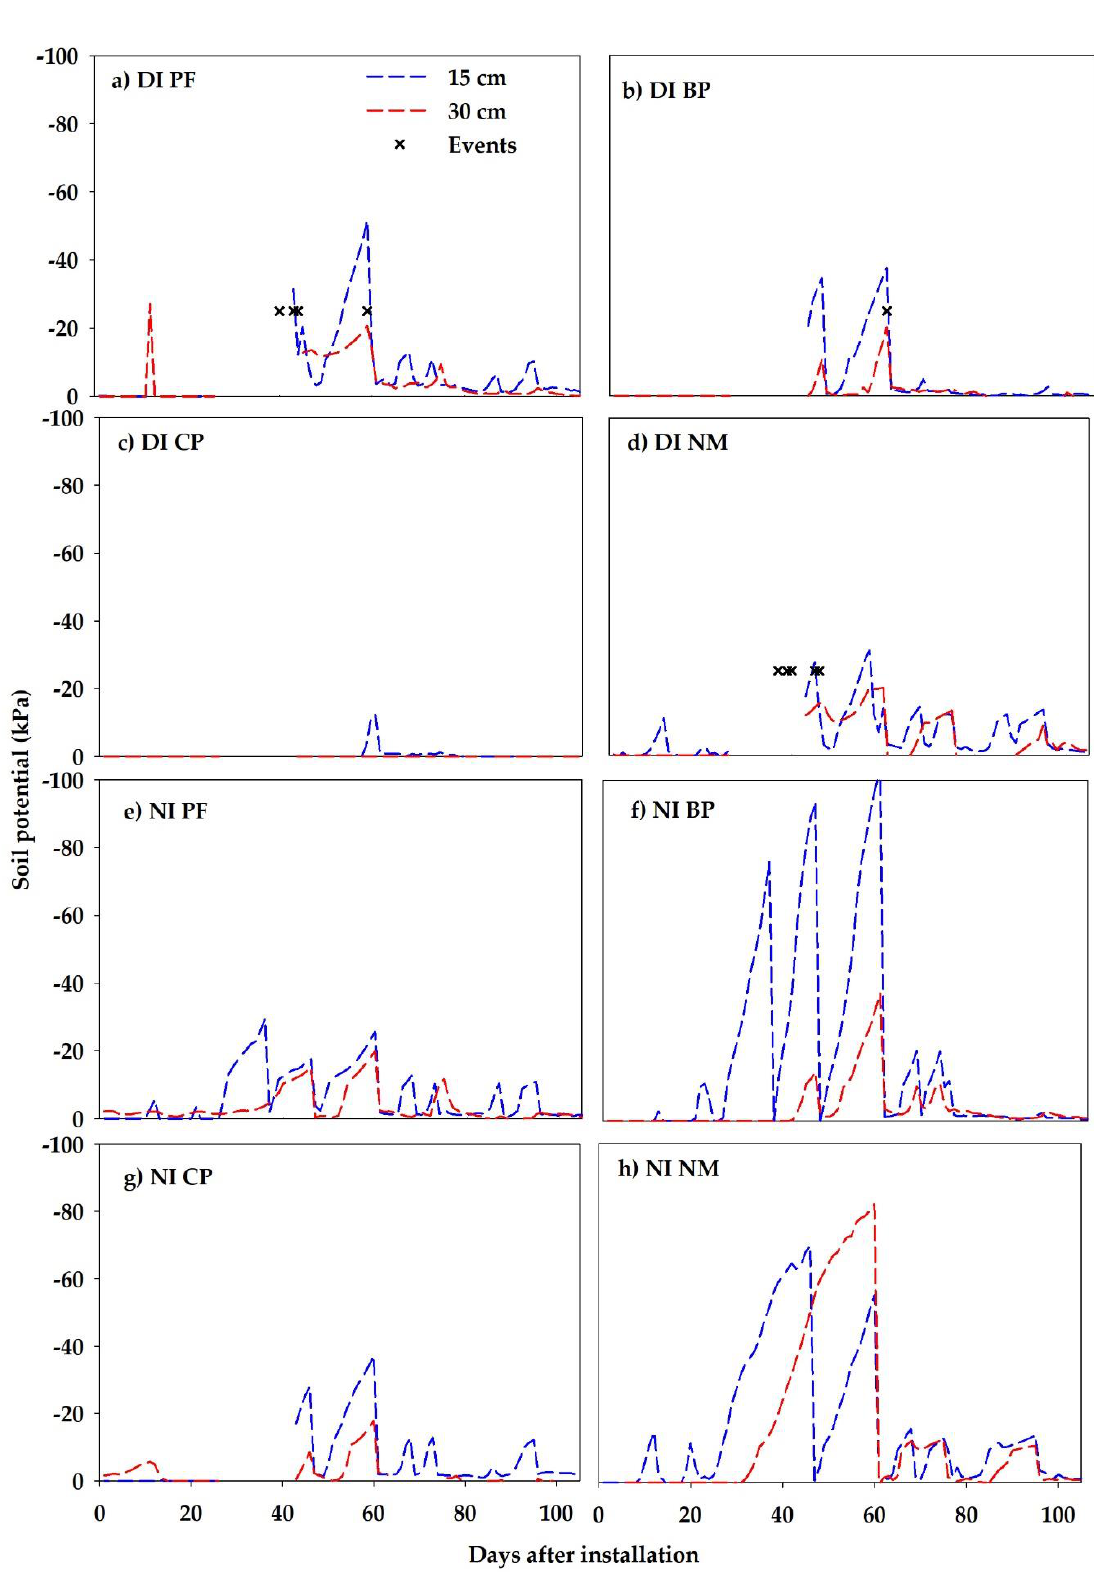
Figure 3. Daily average soil matric potential (09:00 am) at 15 and 30 cm deep in tomato plots during 2019 field experiment under drip irrigation (DI) treatment with ( a ) landscape fabric mulch (DI PF), ( b ) black plastic mulch (DI BP), ( c ) clear plastic mulch (DI CP), ( d ) no mulch (DI NM), and no irrigation treatment (NI) with ( e ) landscape fabric mulch (NI PF), ( f ) black plastic mulch (NI BP), ( g ) clear plastic mulch (NI CP), and ( h ) no mulch (NI NM).